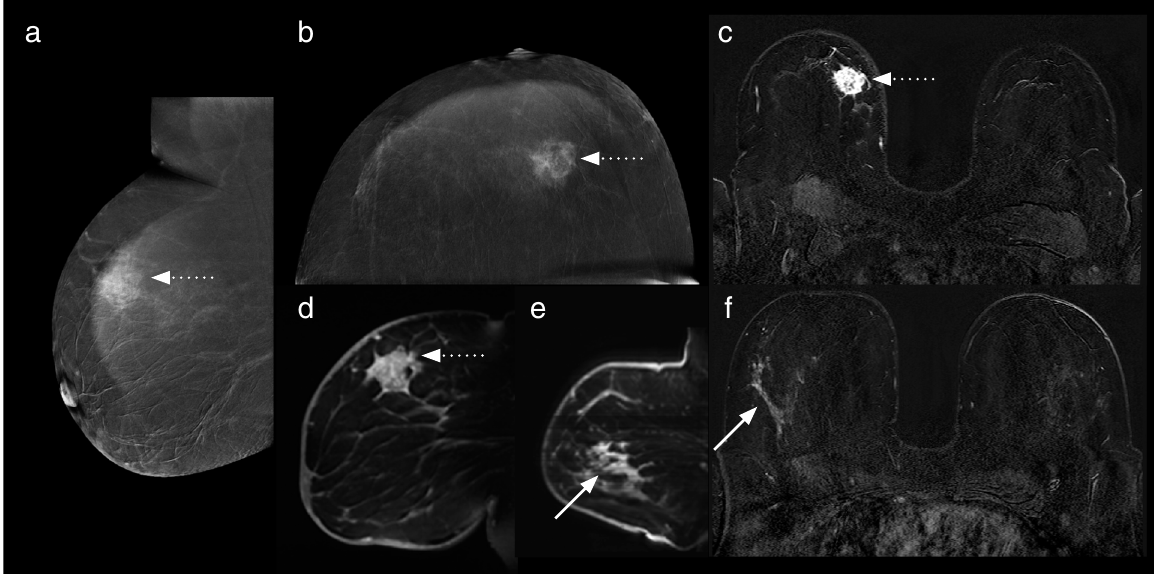
Fig. 4 Case number 2 of Table 3. A 41-year-old woman with a palpable lump in the right breast. Recombined MLO ( a ) and CC ( b ) CEM images and first contrast-enhanced subtracted T1-weighted axial ( c ) and sagittal ( d ) MRI images. The index malignant lesion was a triple-negative, grade 3 invasive ductal carcinoma, seen here as a 15-mm ill-defined, irregularly shaped, heterogeneously enhancing mass (dotted arrows) at the 11 o’clock position in the right breast. Sagittal ( e ) and axial ( f ) post-contrast T1-weighted subtracted images from the MRI study demonstrate an additional lesion in the right lower outer quadrant, a 34-mm segmental area of non-mass enhancement (solid arrows), not visible on CEM. This additional lesion was 30-mm low-grade DCIS. The degree of enhancement of the index lesion on MRI is subjectively much greater than that shown on CEM. The noncalcified DCIS shows minimal enhancement on MRI. CC Craniocaudal, CEM Contrast-enhanced mammography, DCIS Ductal carcinoma in situ , MLO Mediolateral, MRI Magnetic resonance